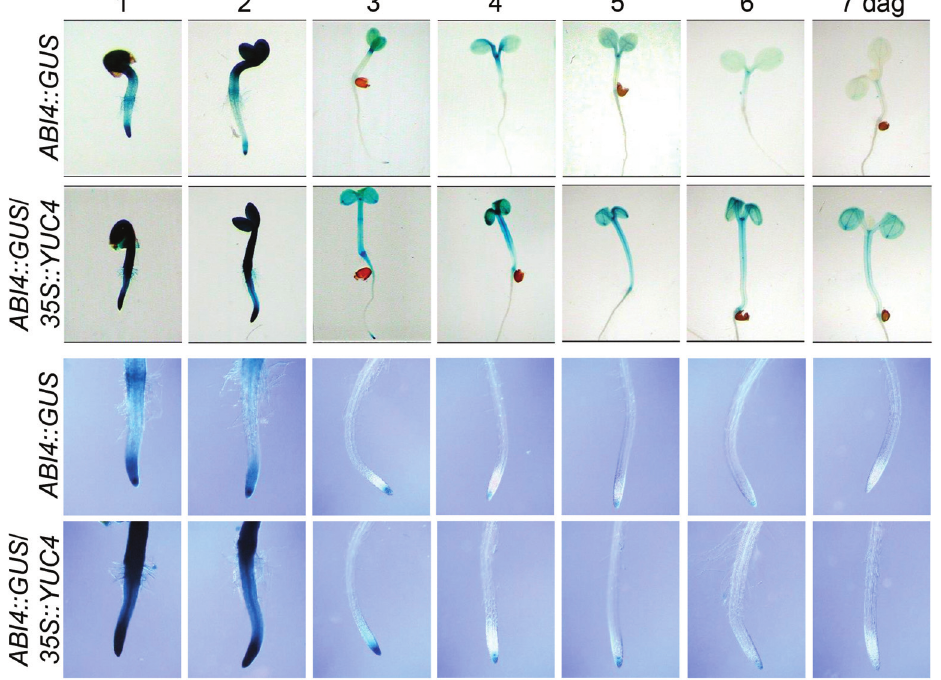
Figure 6 - ABI4::GUS expression in WT and 35S::YUC4 seedlings. ABI4::GUS and ABI4::GUS / 35S::YUC4 seedlings were grown for 7 days and histochemical detection of GUS activity performed daily. Photographs show representative hypocotyls and roots of at least 15 stained seedlings. The ex- periment was repeated three times with similar